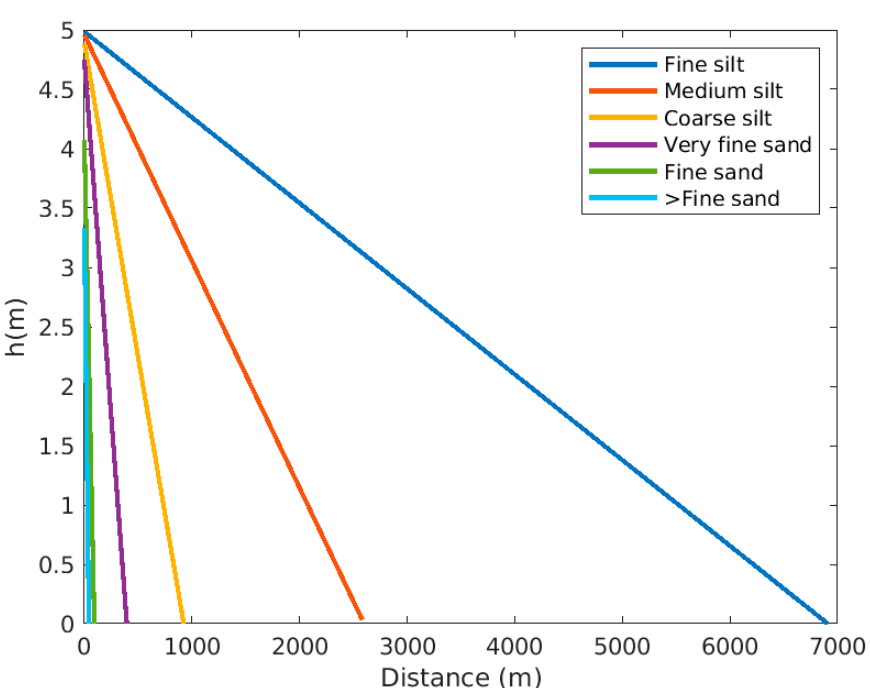
Figure 6. Distance each grain size found in the HSQCS MPA travels for an initial height of 5 m above seabed under a representative maximum 4 h current of 0.35 m/s.